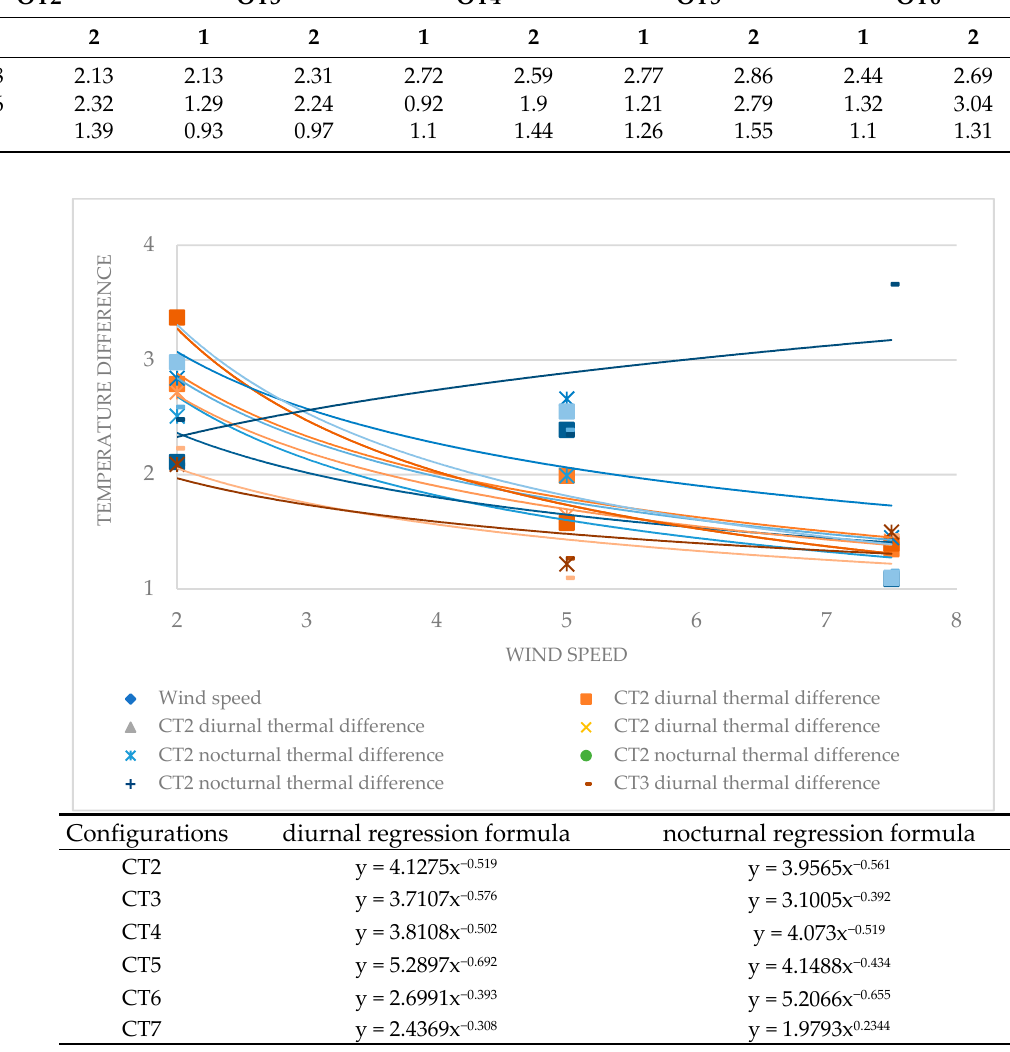
Table 16. Wind speed and diurnal (1) and nocturnal (2) temperature difference in open-type arrangements. Wind Speed